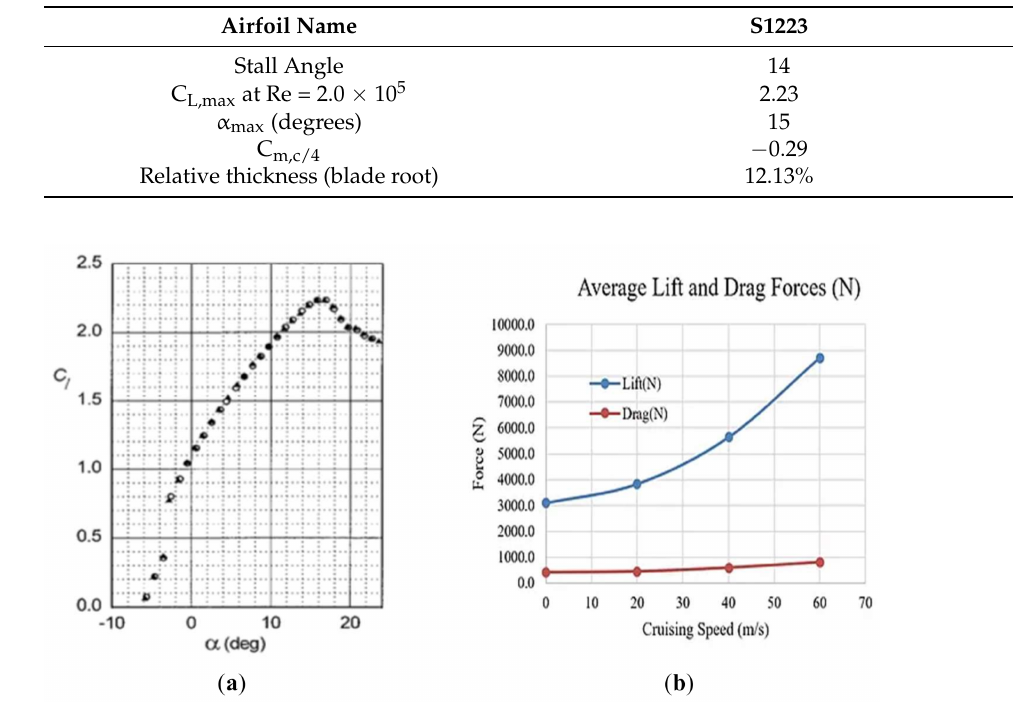
Figure 8. ( a ) A plot of S1223 airfoil lift characteristics as a fixed airfoil. Reprinted from [16]; ( b ) The CFD aerodynamic results of lift/drag vs. cruise speeds for S1223 as a reciprocating wing of 1 m 2 . Reprinted from